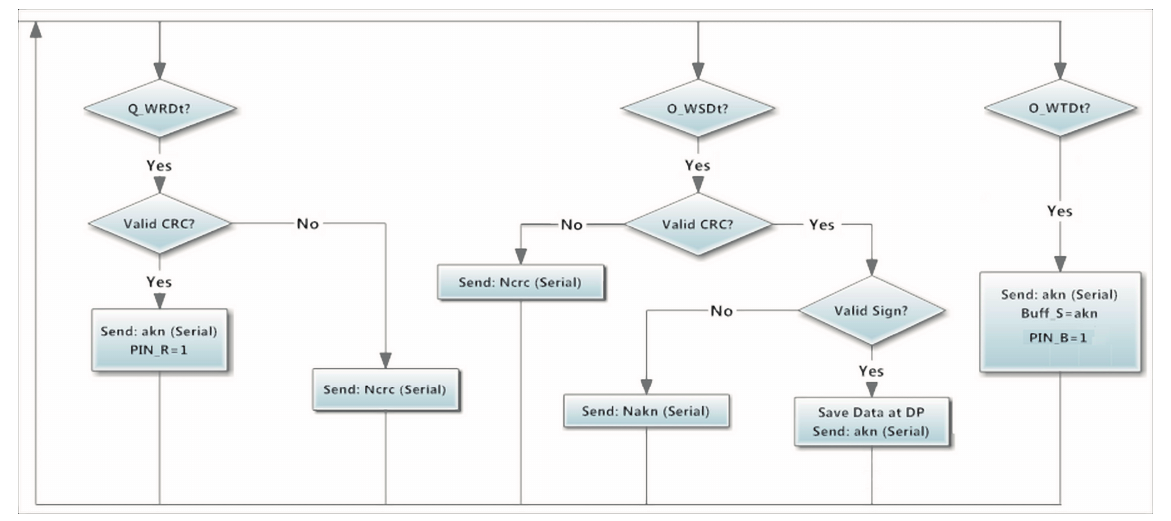
Figure 8. Flowchart of wireless orders from Wireless